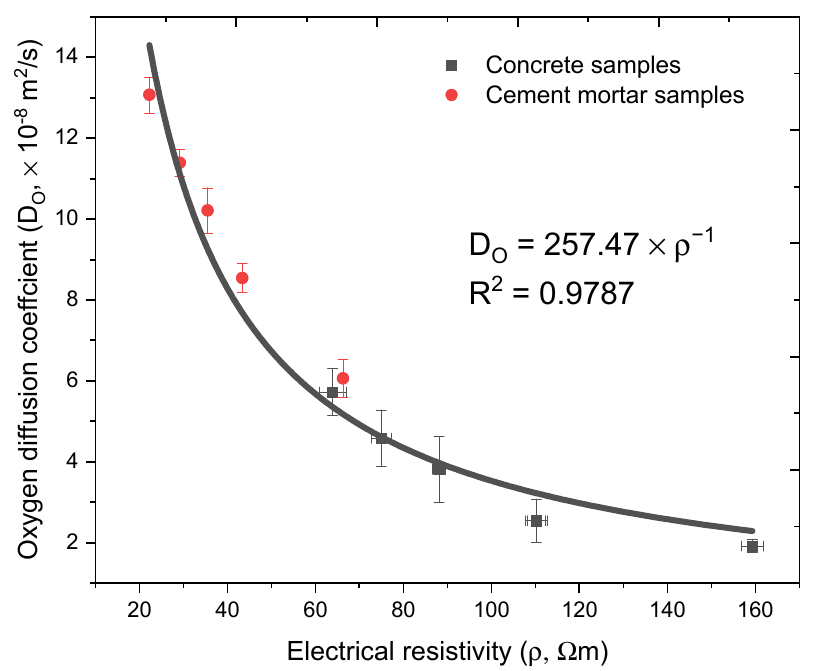
Figure 9. Oxygen diffusion coefficient in terms of electrical resistivity.